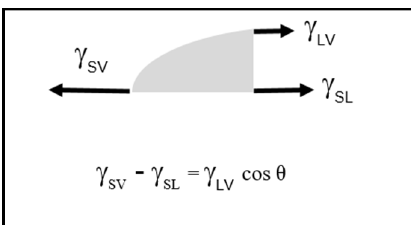
Fig. 9. A prototype of a causal reassignment (see for instance [13]). A correct analysis is given in Figure